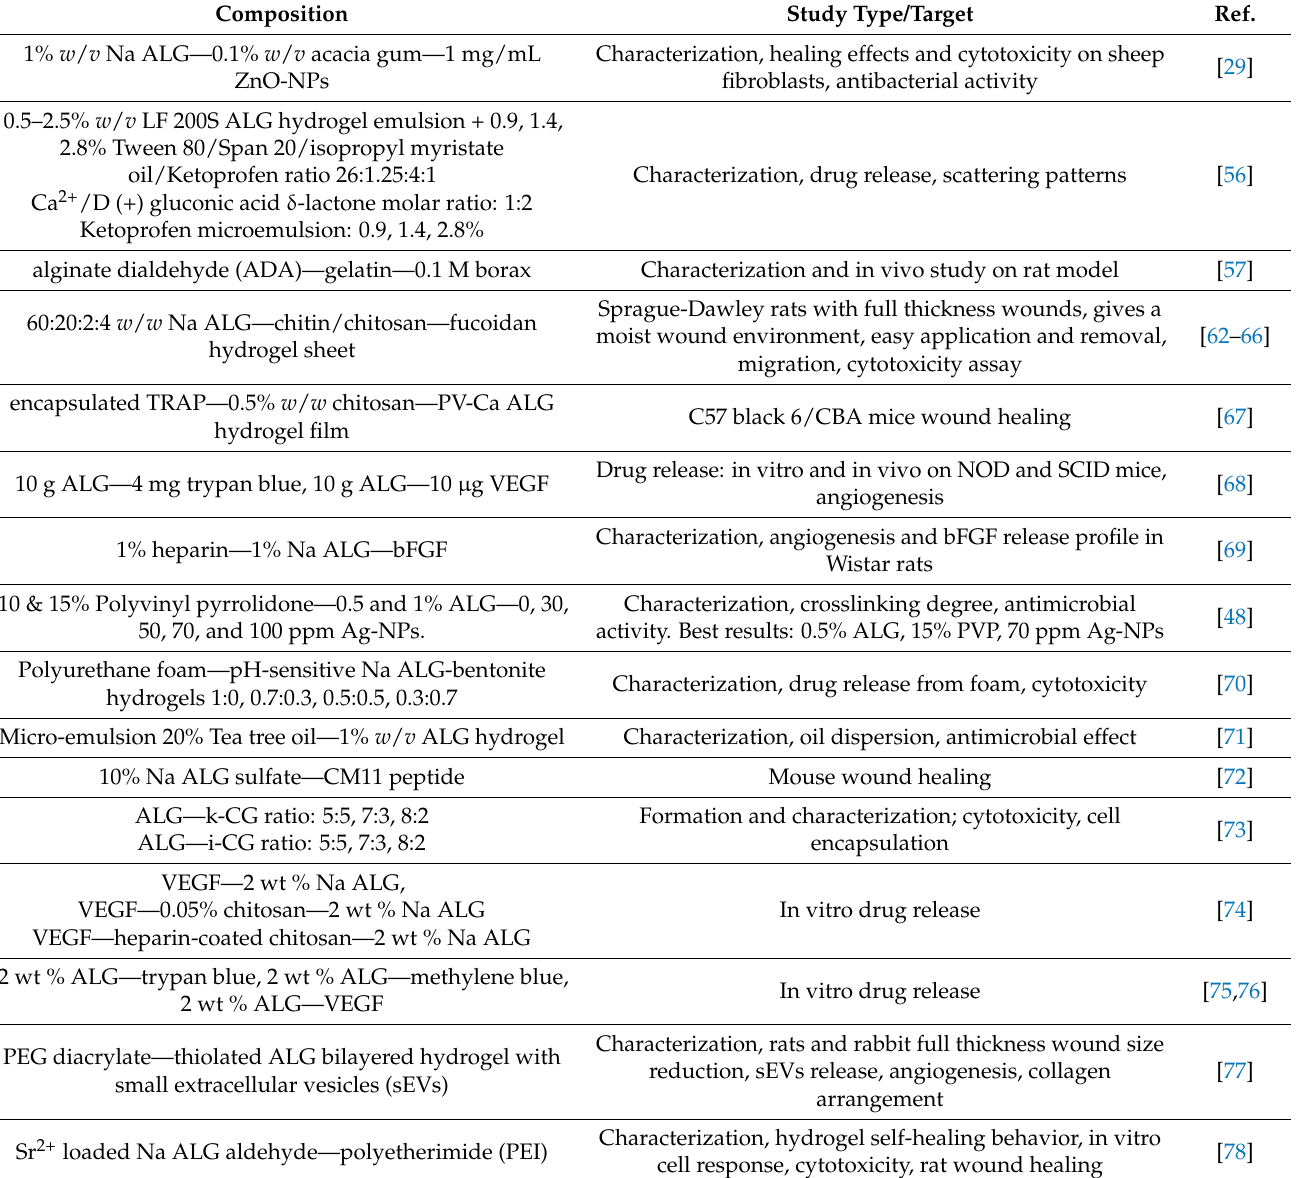
Table 1. Alginate-based hydrogels used for wound